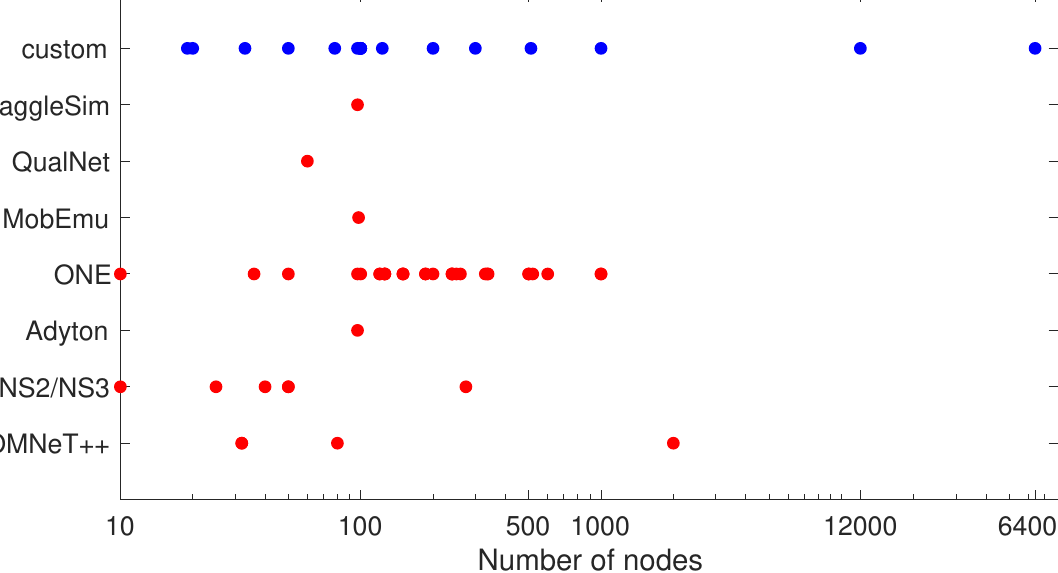
Figure 3. Simulation scale for different simulation environments, for all papers in our surveys which declare the number of